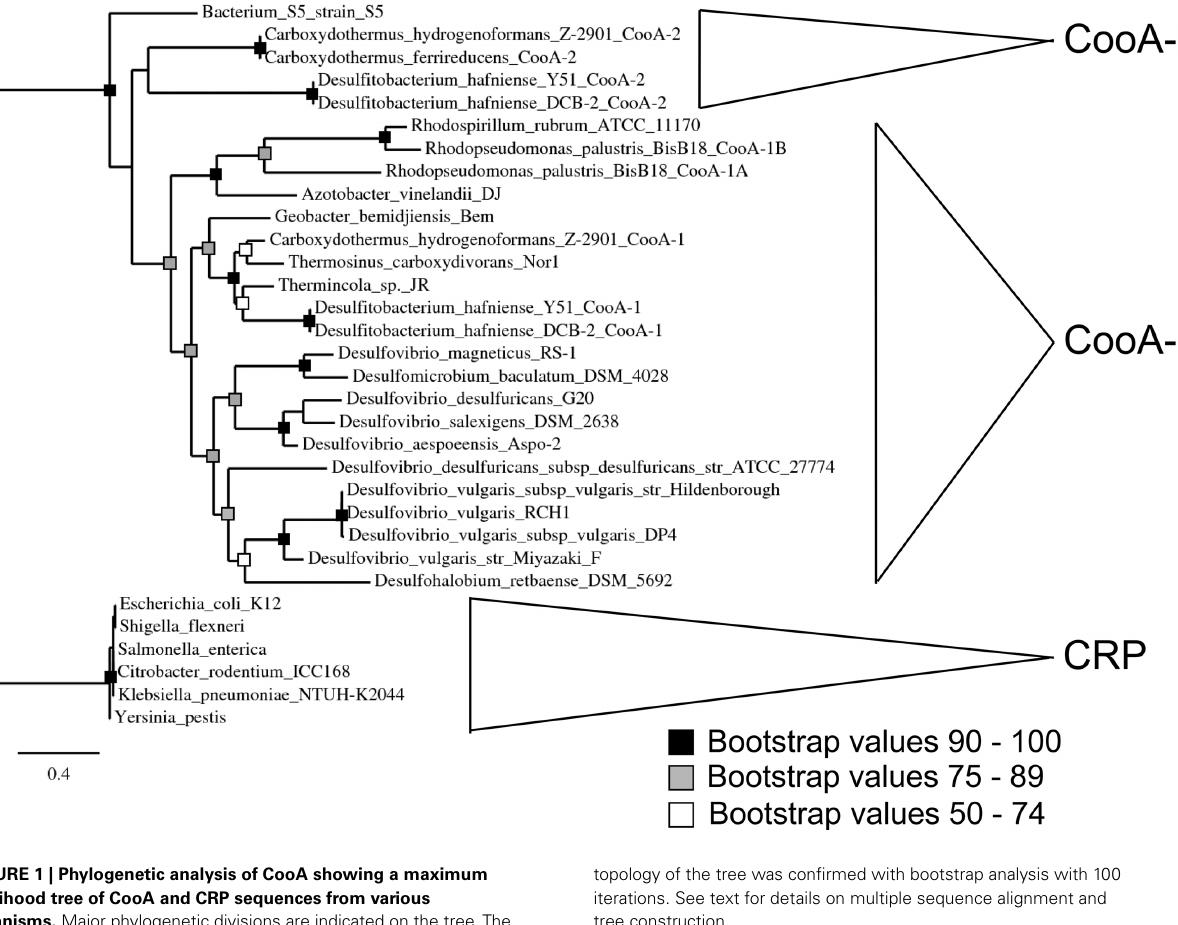
topology of the tree was confirmed with bootstrap analysis with 100 iterations. See text for details on multiple sequence alignment and tree